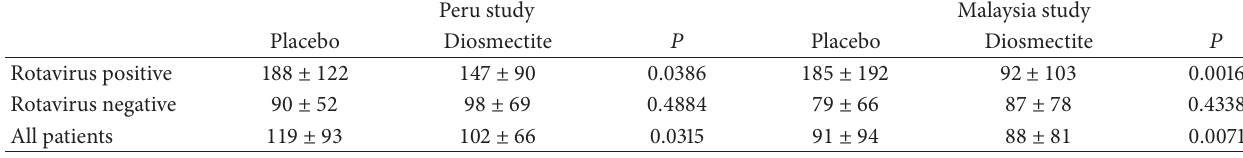
Table 2: Stool output measured in two randomised, placebo-controlled studies of diosmectite for the treatment of acute diarrhoea in children. Data are presented in g/Kg body weight and according to rotavirus status.